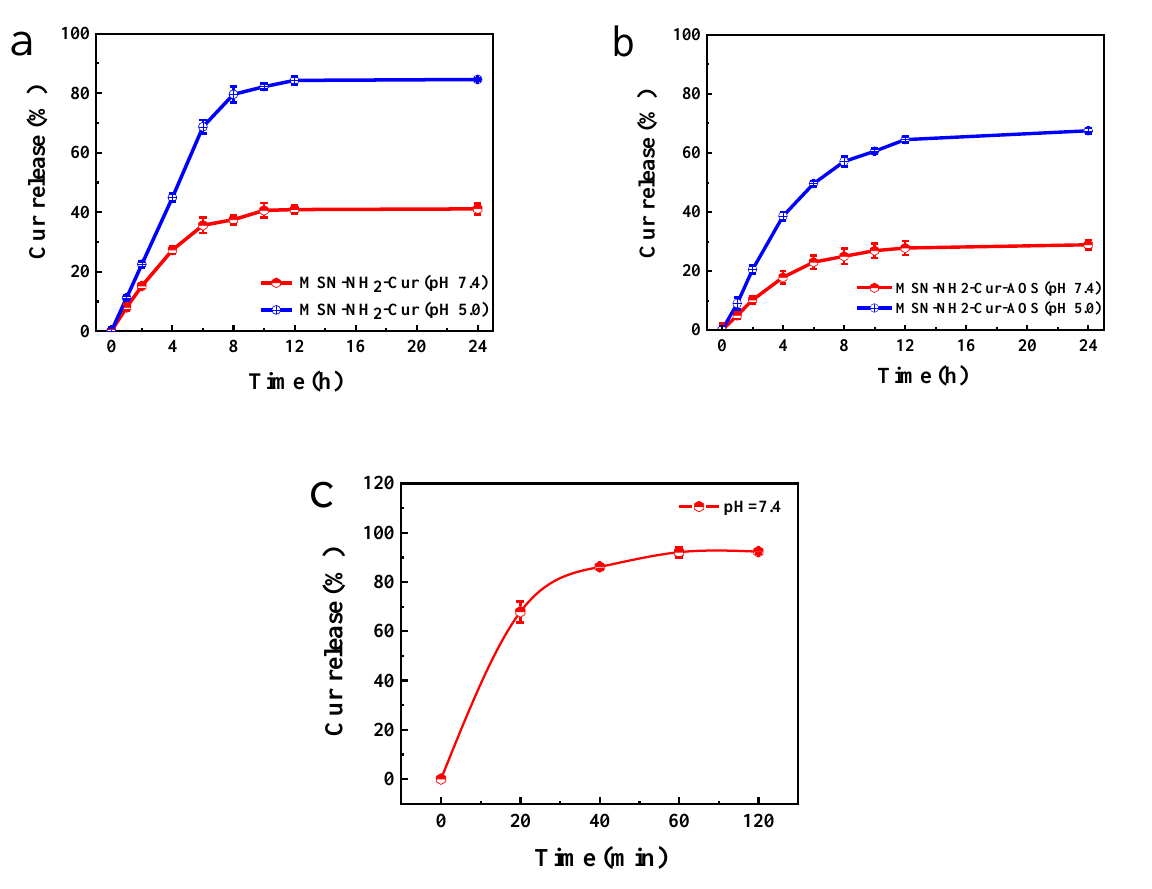
Figure 9. Release rates of Cur from MSN-NH 2 -Cur nanoparticles ( a ) and MSN-NH 2 -Cur-AOS nanoparticles ( b ) under different pH conditions within 24 h. Release rates of curcumin at pH = 7.4 ( c ).